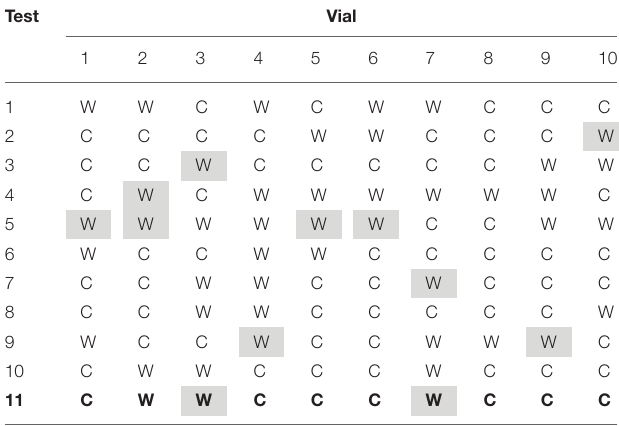
TABLE 1 | Thermocouples positioning in 4R vials–after tray shift. Test Vial